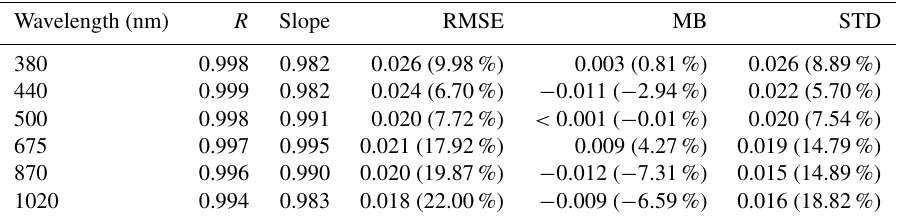
Table 5. Statistics of the comparison between AOD EKO and AOD CIMEL at 380, 440, 500, 675, 870, and 1020nm from June 2020 to March 2021 at the